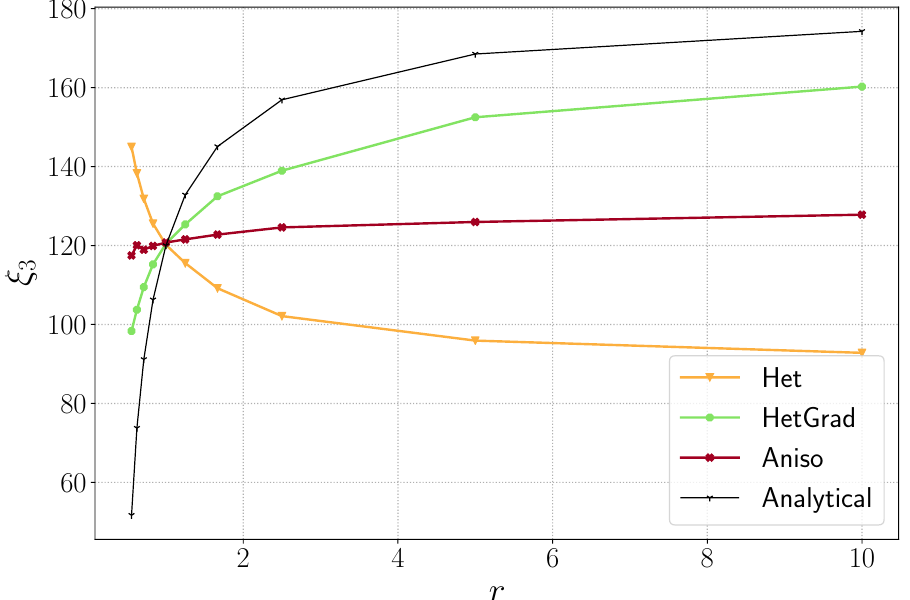
Figure A2. Triangular case with Dirichlet boundary conditions: variation of the triple junction top dihedral angle ξ 3 as a function of r using the Het, HetGrad, and Aniso